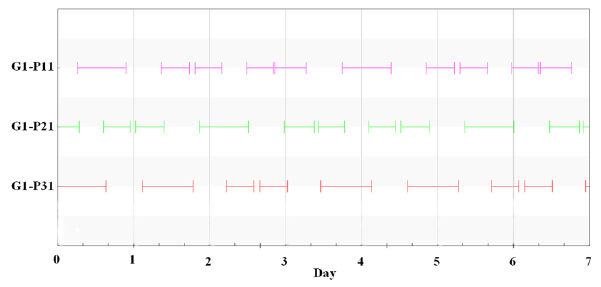
Figure 4: Visibility of the G1 satellite to the MEO satellite.